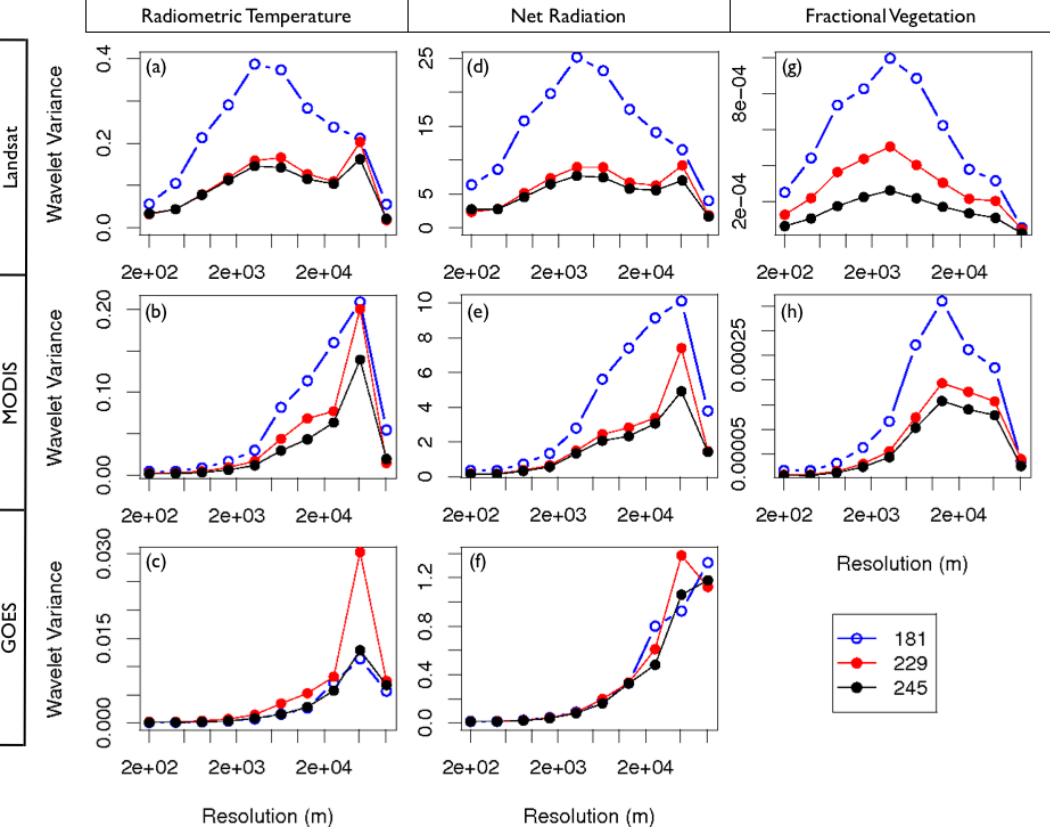
Fig. 3. Spatial wavelet spectra [Power m − 1 ] for radiometric temperature, net radiation, and fractional vegetation for each sensor (Landsat, MODIS, and GOES) for each day of consideration (181, 229, and